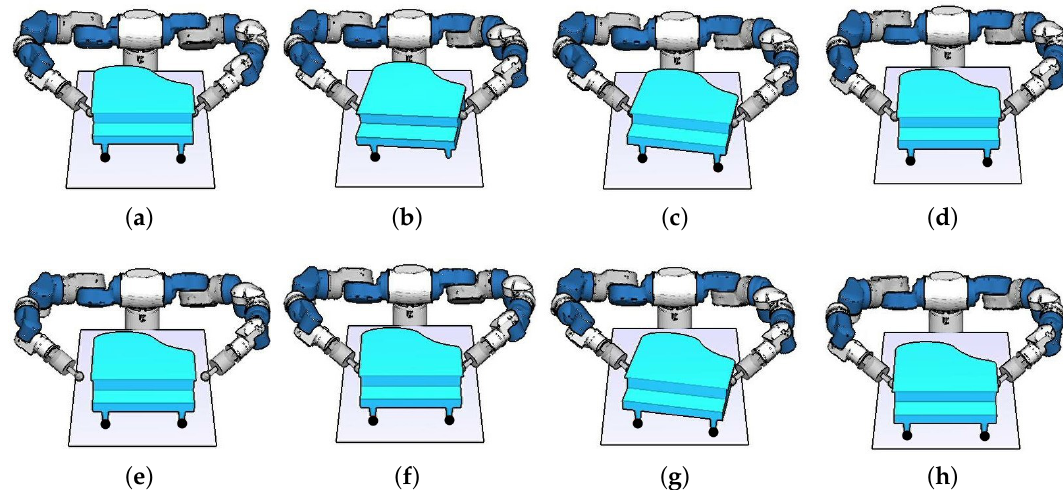
Figure 15. Manipulation of the piano by the robot for moving it forward by pivoting. The support vertices are marked as black dots. The initial configurations are shown in ( a ). The robot manipulates the object by pivoting in ( b – d ). When the joint configurations are close to the limits ( d ), regrasping is performed in ( d – f ). After regrasping, the robot moves the object to the goal pose, see ( f – h ).